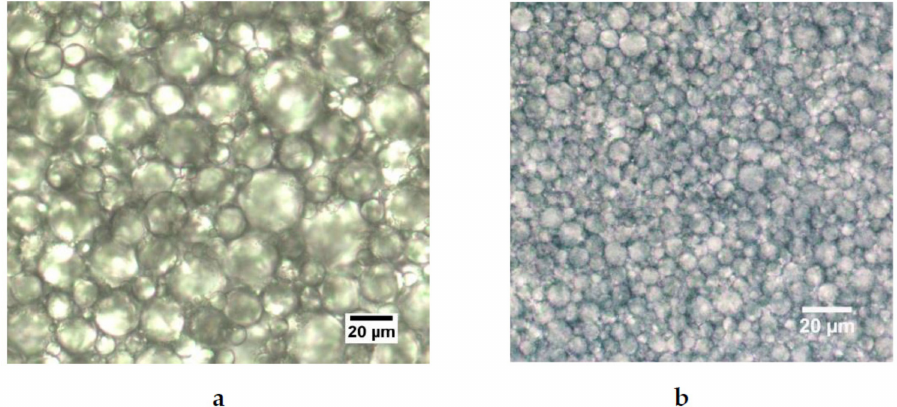
Figure 9. Optical micrographs of reconstructed emulsions of water and 73% w / w oil with WPI ( a ) and Na-Cas ( b ). The magnification is